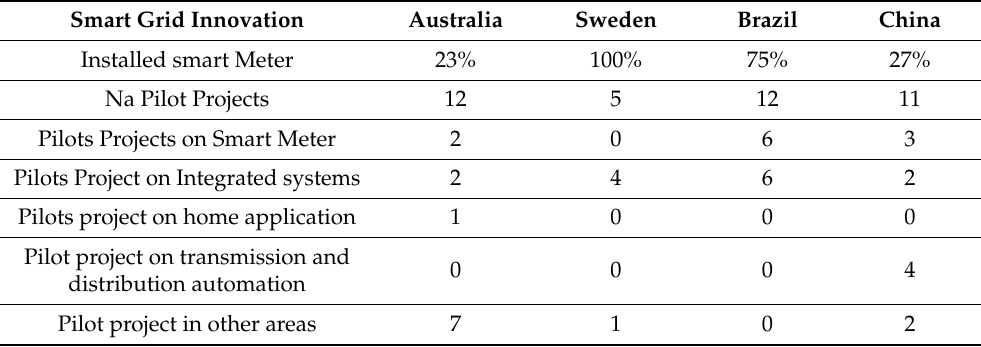
Table 3. A comparative study of country-wise implemented Smart Grid